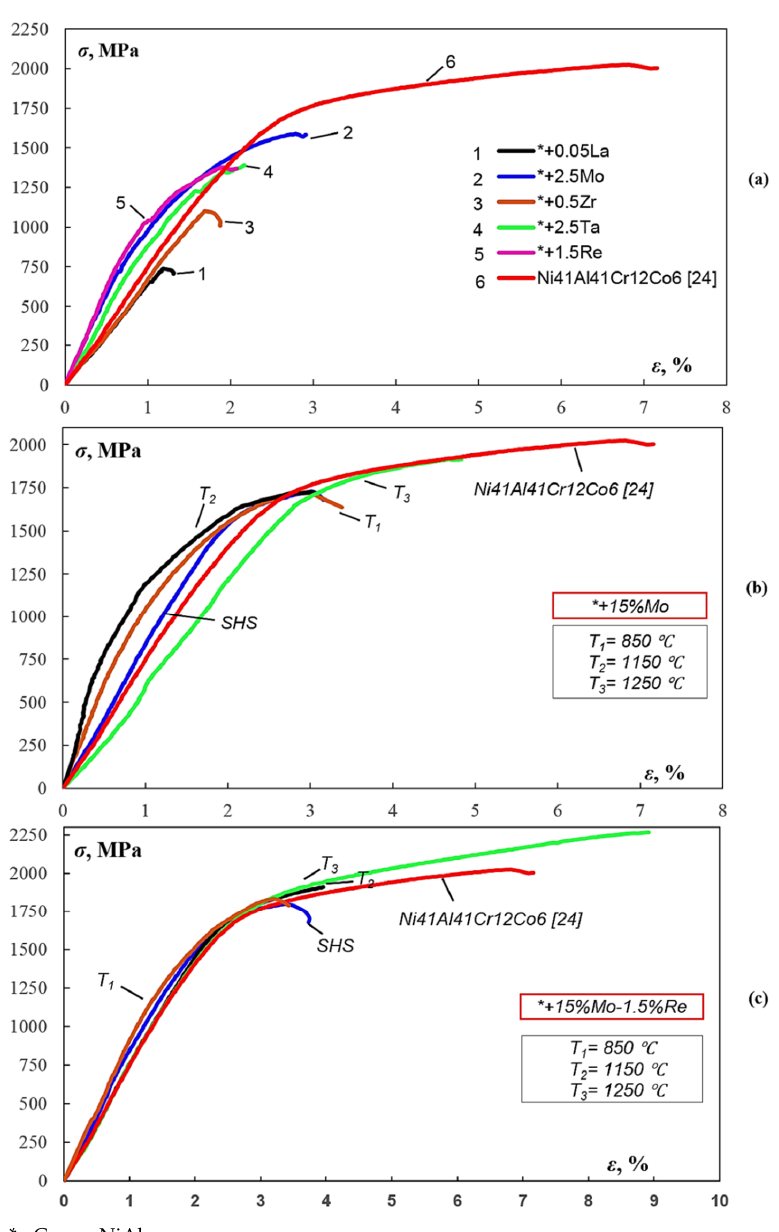
Figure 13. The compressive stress–strain curves of the CompoNiAl+ alloy ( a ) and the alloys doped with 15%Mo ( b ) and 15%Mo + 1.5%Re ( c ).